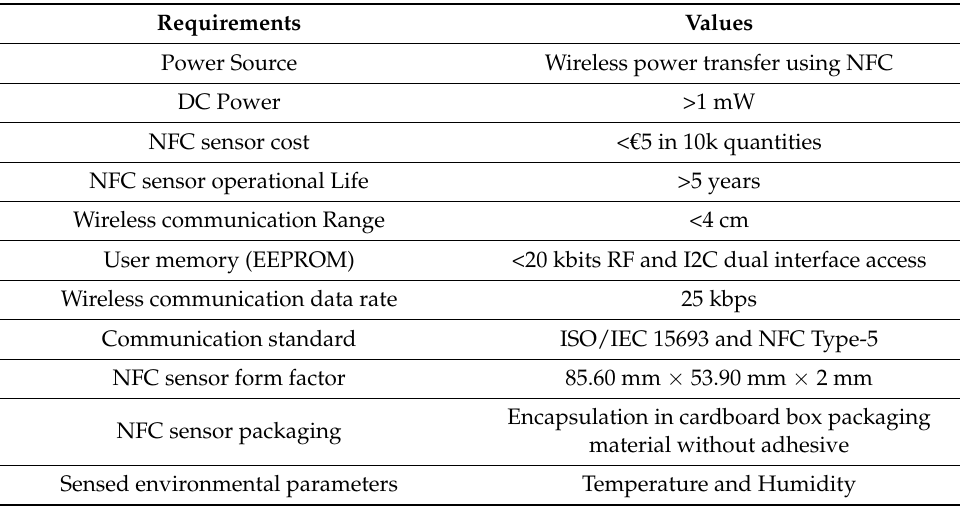
Table 1. NFC sensor technical and user